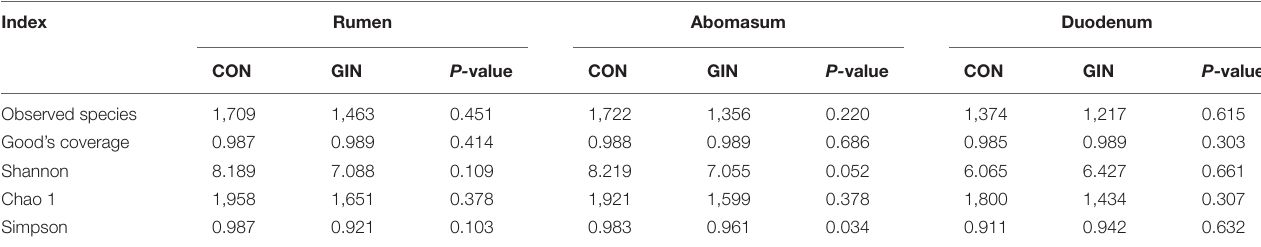
TABLE 4 | Alpha diversity index of microbiota in rumen, abomasum and duodenum of lambs infected with Haemonchus contortus